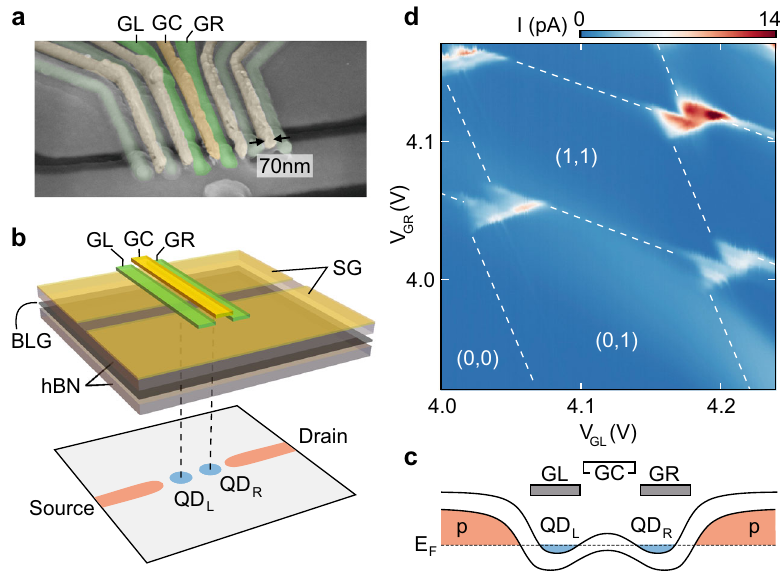
Fig. 2 Device tuning. a False-color scanning electron micrograph of the metallic gates. A pair of split gates de fi nes the conducting channel, which can be modulated by voltages applied to the fi nger gates. The gates used in the following are color coded. b Schematic cross-section of the device. The upper part shows the metallic gates on top of the hBN/BLG/hBN van-der-Waals heterostructure. The lower part color codes the charge carrier density within the channel and the two quantum dots (red: holes and blue: electrons). c Schematics of the band edge pro fi le along the narrow channel, highlighting how the fi nger gates are used to form a DQD consisting of QD L and QD R connected to the p-type conducting channel. d Charge stability diagram showing the current through a double quantum dot as function of the potential applied to the two gate fi ngers, V GL and V GR . A constant bias voltage of V b = 1 mV is applied and the central fi nger gate voltage is kept at V GC = − 4